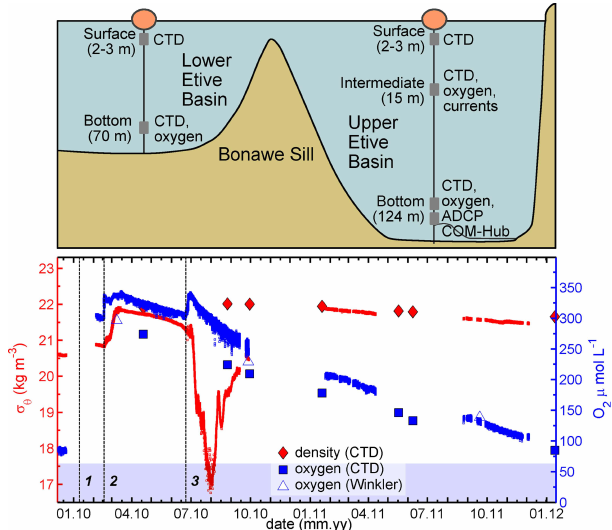
Fig. 9. Upper panel: schematic of the Loch Etive Cabled Observa- tory (“LECO”, mooring depicted on the right-hand side) and the autonomous installation, including delay mode thermistors (NERC Diving Unit), installed in the lower basin seawards of the Bonawe Sill (depicted on the left-hand side). The time series in the lower panel originate from LECO’s lowermost sensor unit. Lower panel: potential density (red line) and dissolved oxygen measured with an oxygen optode (type 3835, AADI, Bergen, Norway; blue line) at the HYPOX mooring site in upper Loch Etive at 124m water depth. Blue squares and red diamonds represent validation data from CTD casts obtained with various instruments (SBE19 + , SBE16, SBE9, equipped with SBE oxygen sensors, Seabird Electronics, Belle- vue, WA, USA). The blue triangles represent oxygen concentra- tions in samples measured by Winkler titration. The three overturn- ing events observed ( ∼ 10 January, 17–23 February, 23–30 June 2010) are indicated by dashed vertical lines. Gaps in the records resulted from cable connection/instrument failure, repair and re- deployments. During the third renewal event, vertical stratification was destroyed and surface waters were transported to the bottom. Stratification recovered with the occurrence of heavy rains in early July; however, bio-fouling in the conductivity cell led to the ap- parent extended presence of low-density waters at depth. The gray area denotes hypoxic conditions with oxygen concentrations below 62.5µmolL − 1 .